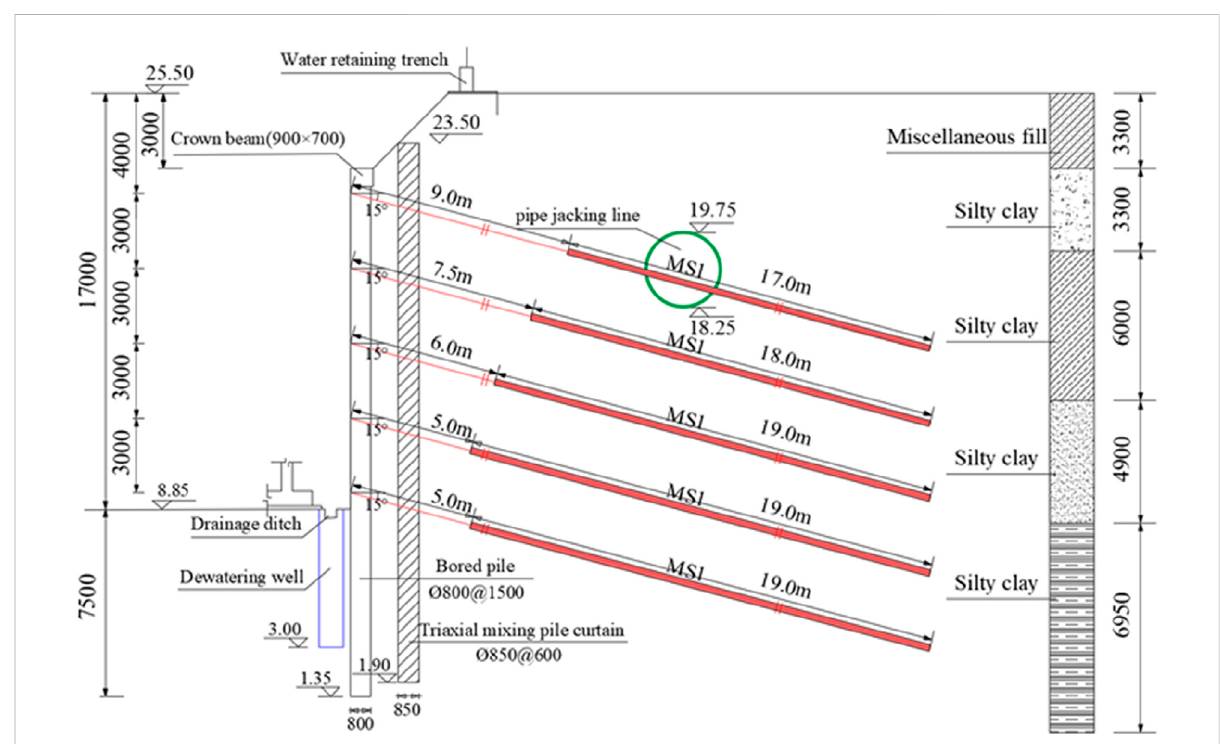
FIGURE 2 Pro fi le of the retaining structure for the deep excavation of the sewage treatment plant.